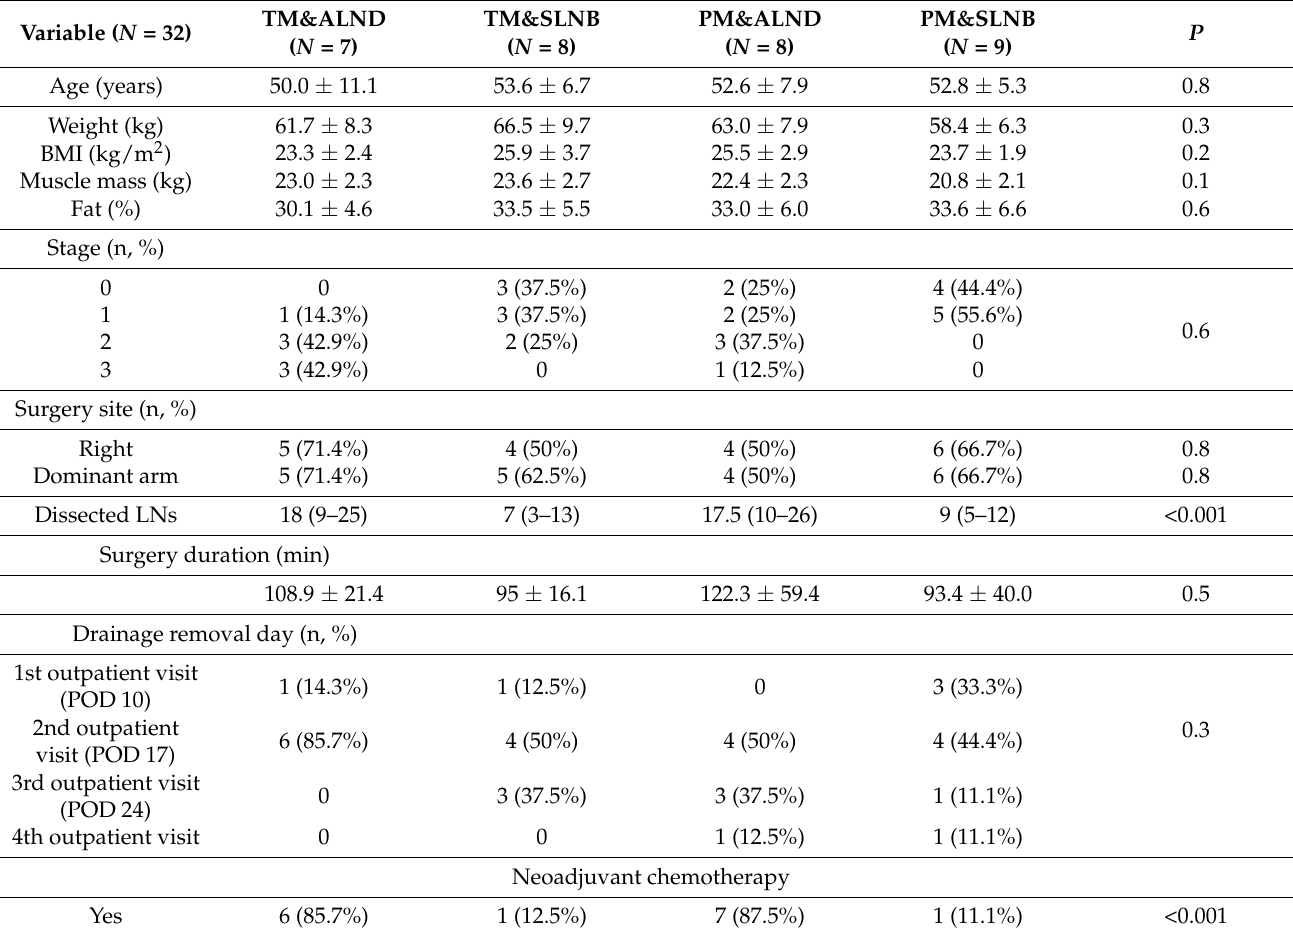
Table 1. Participants’